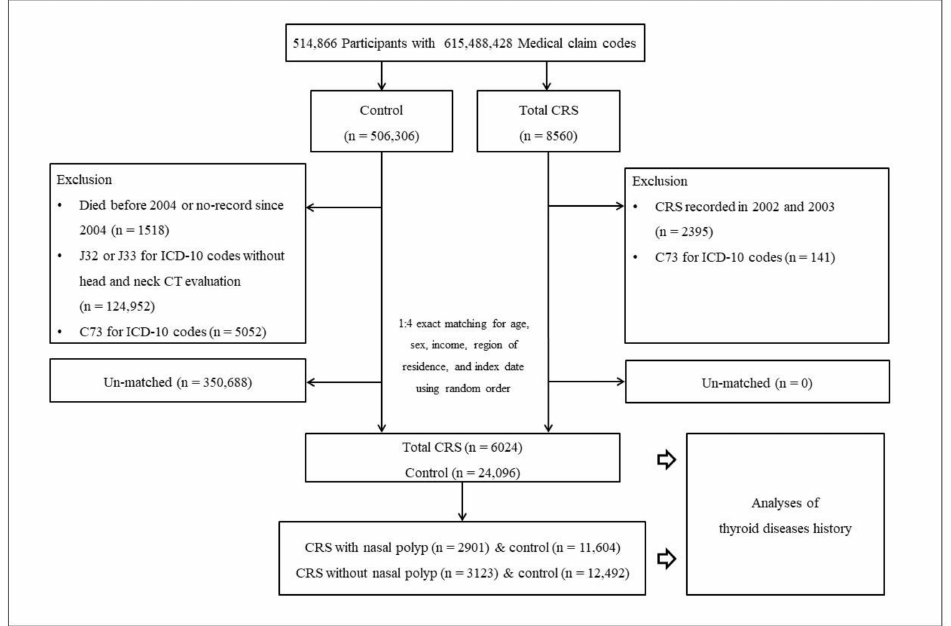
Figure 1. A schematic representation of the current study’s participant selection process. A total of 6024 eligible patients with chronic sinusitis (CRS) were matched with 24,096 control participants for age, sex, income, and region of residence out of a total of 514,866 participants. Study participants were regrouped into the following subgroups: patients with CRS with nasal polyps (n = 2901) and matched controls (n = 11,604), and patients with CRS without nasal polyps (n = 3123) and matched controls (n =